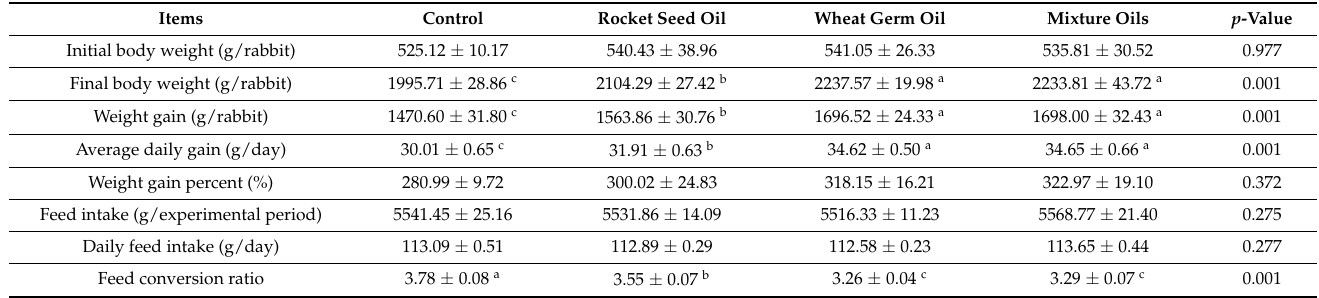
Table 2. Growth performance, feed intake, and feed conversion ratio of V-line growing rabbits (5–12 weeks of age) that were administered orally with rocket seed oil, wheat germ oil, and their mixture.